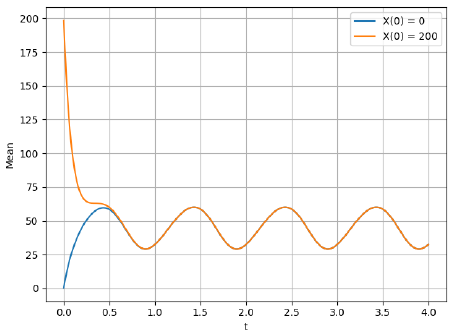
Figure 8. Average E ( t , k ) for t ∈ [ 0,4 ] .